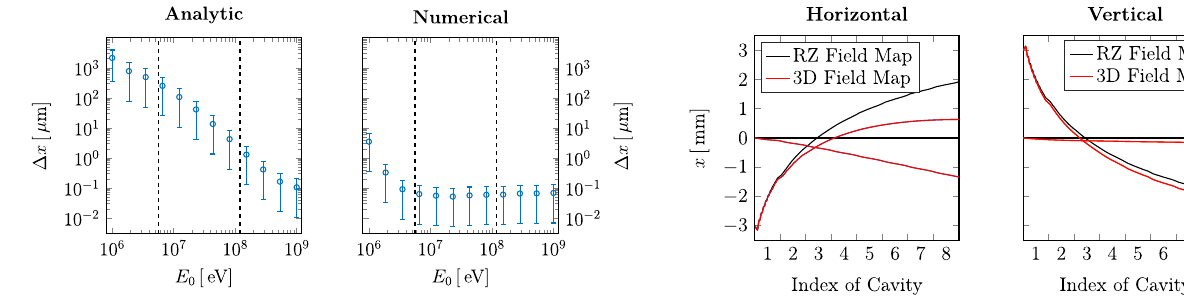
FIG. 3. Particle trajectories through eight cavities for two different initial conditions, plotted for the horizontal (left) and vertical (right) plane. The red lines show the solution of the equation of motion using the 3D field map, the black lines correspond to the solution obtained via the axially symmetrical (RZ) field map. The initial beam parameters are the same for both maps. The initial beam energy is E 0 ¼ 5 MeV. Note the strong cavity focusing in the first